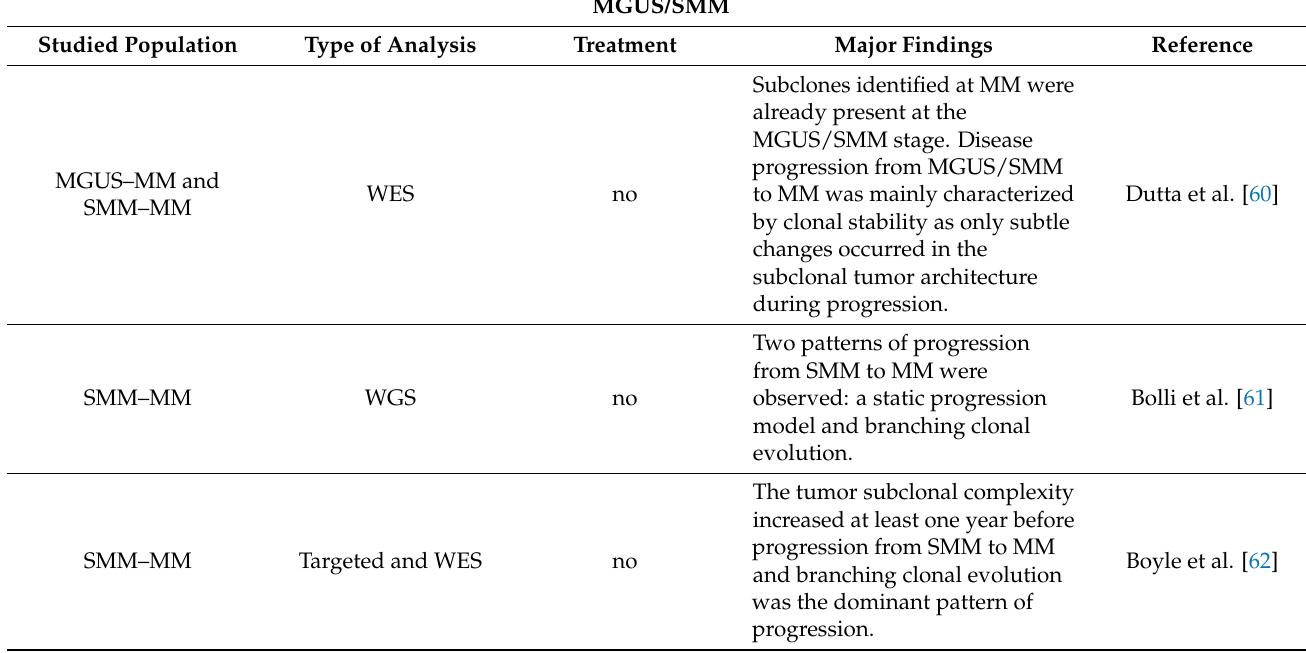
Table 1. Selected studies using next-generation sequencing to track clonal evolution in MGUS, SMM, and MM. Abbreviations: MGUS, monoclonal gammopathy of undetermined significance; SMM, smoldering multiple myeloma; MM, multiple myeloma; WES, whole-exome sequencing; WGS, whole-genome sequencing; Dx, diagnosis; VTD, bortezomib, thalidomide, dexamethasone; autoHSCT, autologous hematopoietic stem cell transplantation; NDMM, newly diagnosed MM; RRMM, relapsed/refractory MM; OS, overall